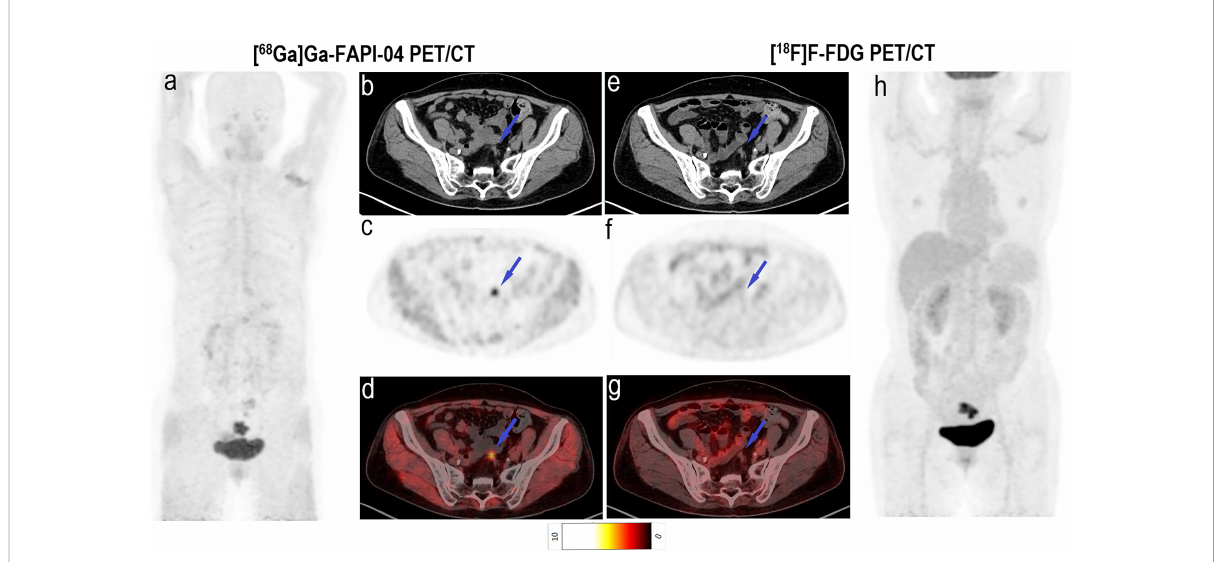
FIGURE 4 Images of a 64-year-old woman with rectal cancer for staging. (A) Mean intensity projection images of [ 68 Ga]Ga-FAPI-04 PET/CT scan. (B – D) Axial CT, PET and fused images of [ 68 Ga]Ga-FAPI-04 PET/CT scan. (E – G) Axial CT, PET and fused images of [ 18 F]F-FDG PET/CT scan. (H) Mean intensity projection images of [ 18 F]F-FDG PET/CT scan. Pelvic peritoneal carcinoma is distinctly observed in [ 68 Ga]Ga-FAPI-04 PET/CT images (blue arrows in b – d ) because of intensive tracer uptake (SUV max 5.5). Conversely, little [ 18 F]F-FDG (SUV max 1.1) uptake results in the small lesion being hardly detectable (blue arrows in E – G ).